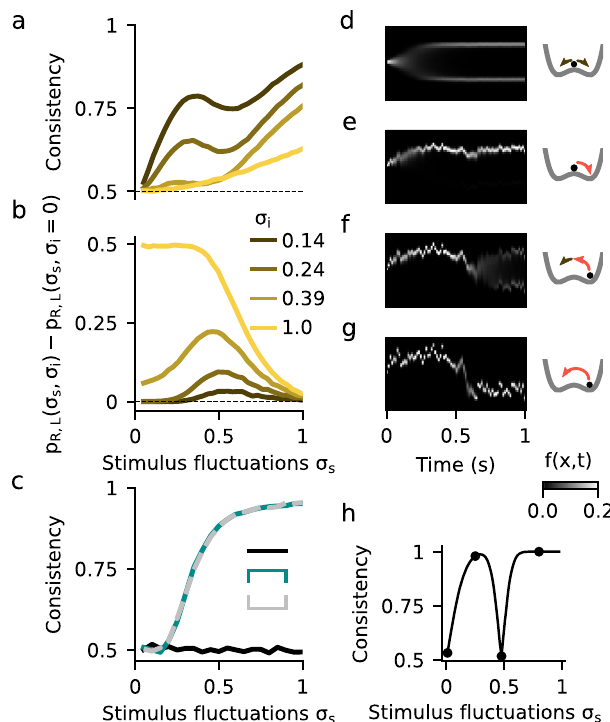
Fig. 4 Dependence of choice consistency on stimulus fl uctuations. a Average consistency versus stimulus fl uctuations σ S for different values of the internal noise σ I (see inset in b ). b Difference between the transition probabilities with ( p R , L ( σ S , σ I )) and without ( p R , L ( σ S , σ I = 0)) internal noise. The drop in consistency coincides with an increase of this difference revealing the σ S -range in which transitions occurred because of the cooperation of internal and stimulus fl uctuations. c Consistency versus σ S for the canonical models. The consistency of the perfect integration is at chance level because we used stimuli with exactly zero integrated evidence (see Methods). d – g Temporal evolution of the decision variable probability distribution f ( x,t ) for an example stimulus in the different regimes of σ S : for negligible σ S the choice is driven by the internal noise and the consistency is very low (53.2%, d ). For small σ S , when the stimulus determines the fi rst visited attractor but fl uctuations are not strong enough to produce transitions, the consistency is very high (97.8%, e ). For intermediate σ S , the transitions can only occur when σ I and σ S work together to cause a large fl uctuation. Because the internal noise has again impact on the choice, the consistency decreases (51.7%, f ). For large σ S , the stimulus fl uctuations are strong enough to produce transitions by itself and the consistency is again very high (100%, g ). h Consistency versus σ S obtained just using the example stimulus shown in d – g (points mark the σ S values shown in d – g ). Mean stimulus evidence was μ = 0 in all